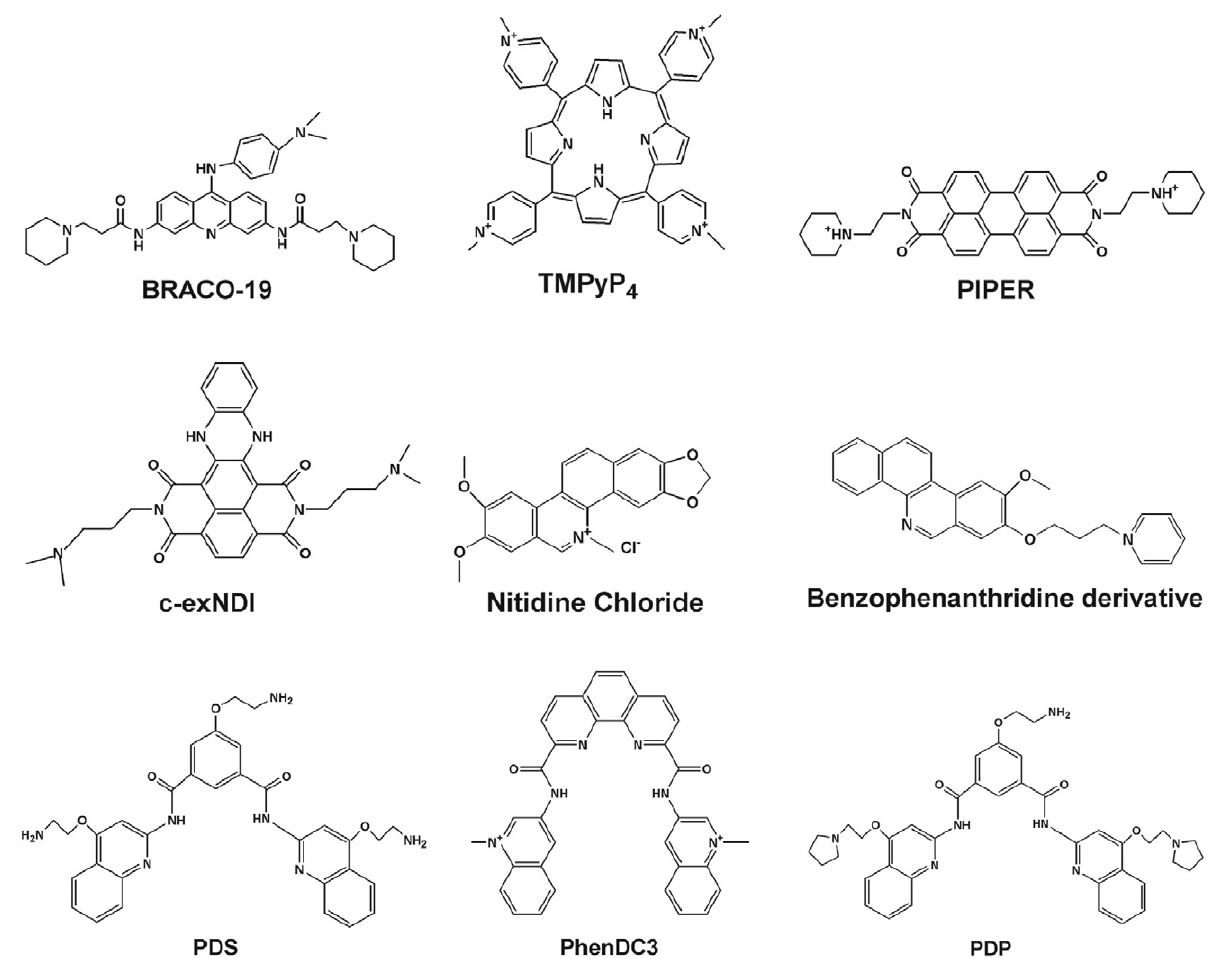
Figure 8. Chemical structures of ligands that prefer G4s in viral